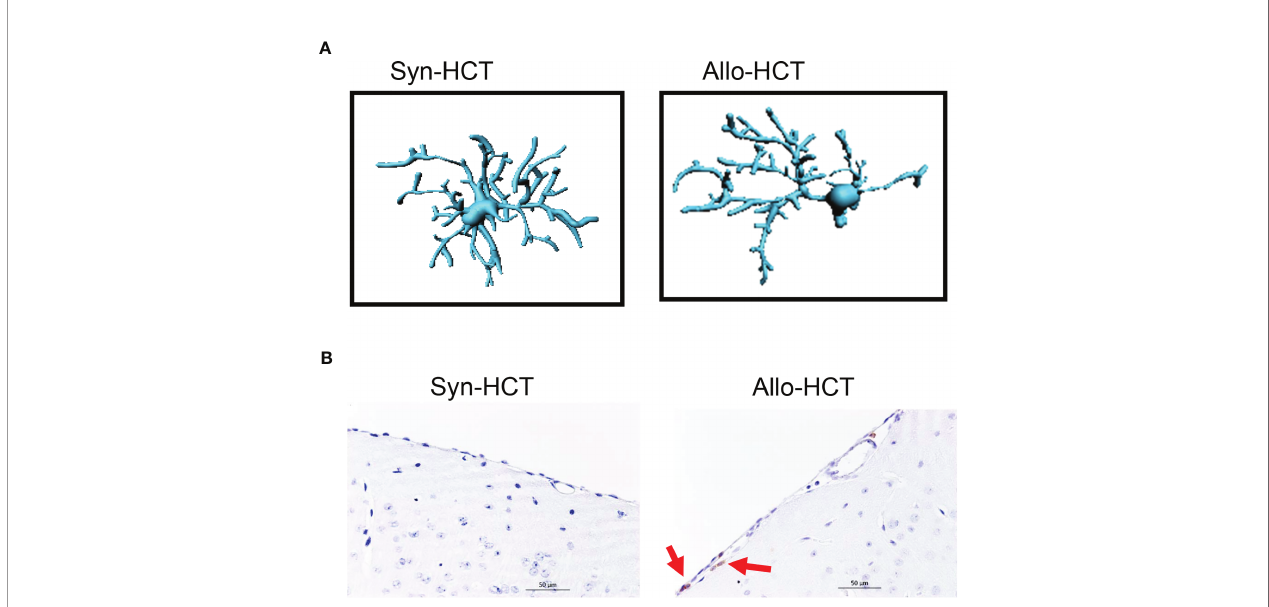
FIGURE 1 | (A) Microglia morphology in the CNS of mice undergoing syn-HCT or allo-HCT as previously reported (26). (B) In fi ltration of T cells (brown) in the CNS of mice undergoing syn-HCT or